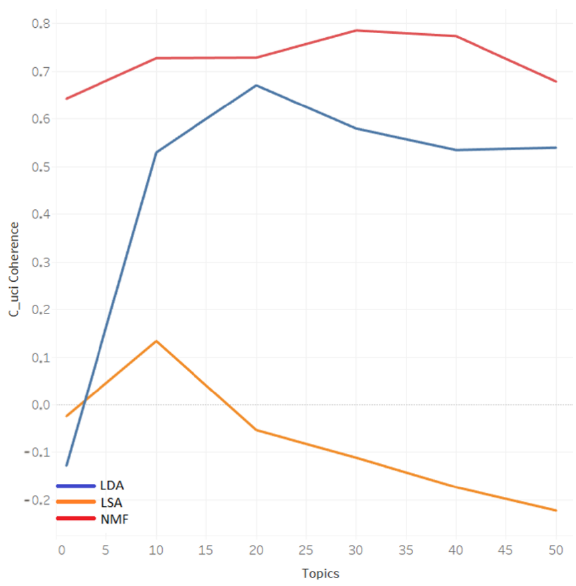
Figure 8. C_uci umass of LDA, LSA, and NMF with a k of 1 through